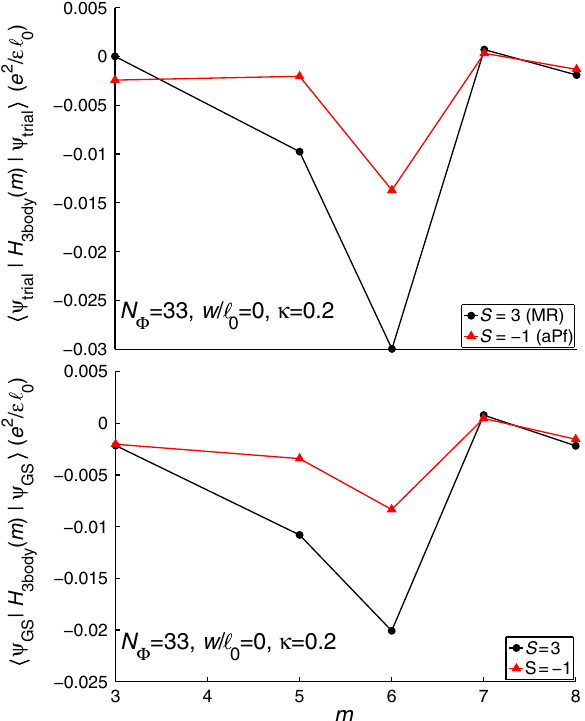
FIG. 3. Top panel: Expectation value of the three-body terms in the MR and aPf trial wave functions as a function of angular j H ð m Þj Ψ i where H ð m Þ ¼ momentum m , i.e., h Ψ 3 body 3 body trial trial P ˆ P V ð 3 Þ ð w= l ; κ Þ ð m Þ , and Ψ ¼ Ψ or Ψ . Bottom m 0 ijk i<j<k trial MR aPf panel: Expectation value of the three-body terms for the S ¼ 3 and S ¼ − 1 ideal Coulomb ground states as a function of angular momentum m .